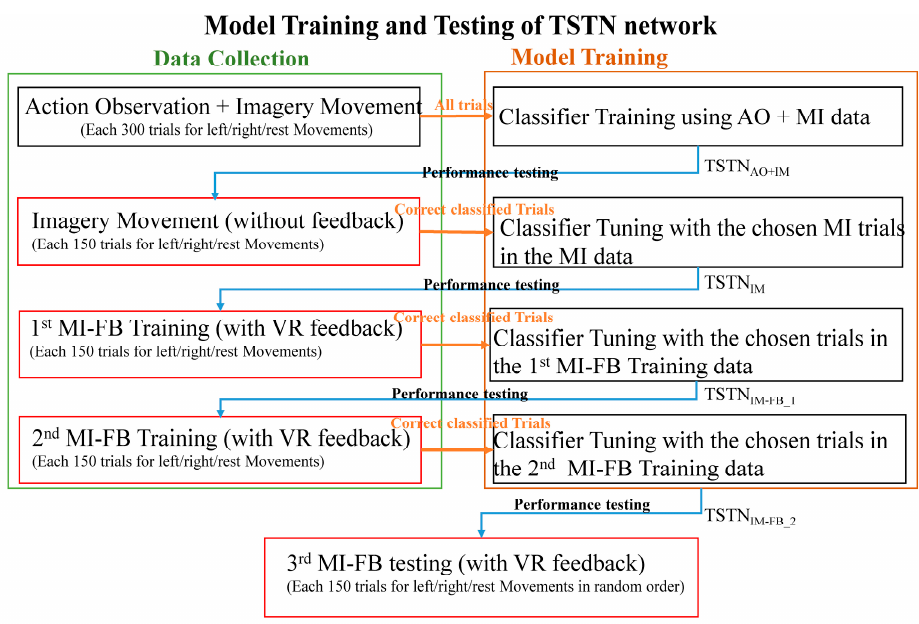
Figure 4. The training and testing procedure for the AO + MI, MI, 1st MI-FB, 2nd MI-FB, and 3rd MI-FB datasets.